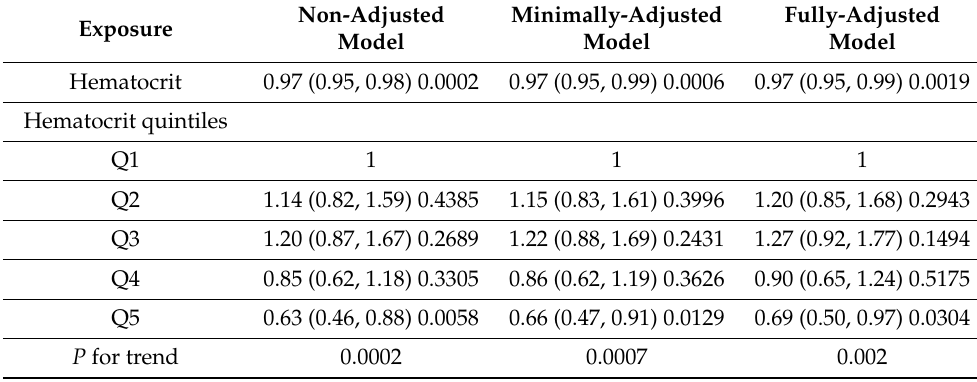
Data in table: OR (95% CI) , p -value. Outcome variable: preoperative DVT. Exposure variable: hematocrit level at admission. Minimally-adjusted model: adjust for sex. Fully-adjusted model: adjust for sex, dementia, and multiple